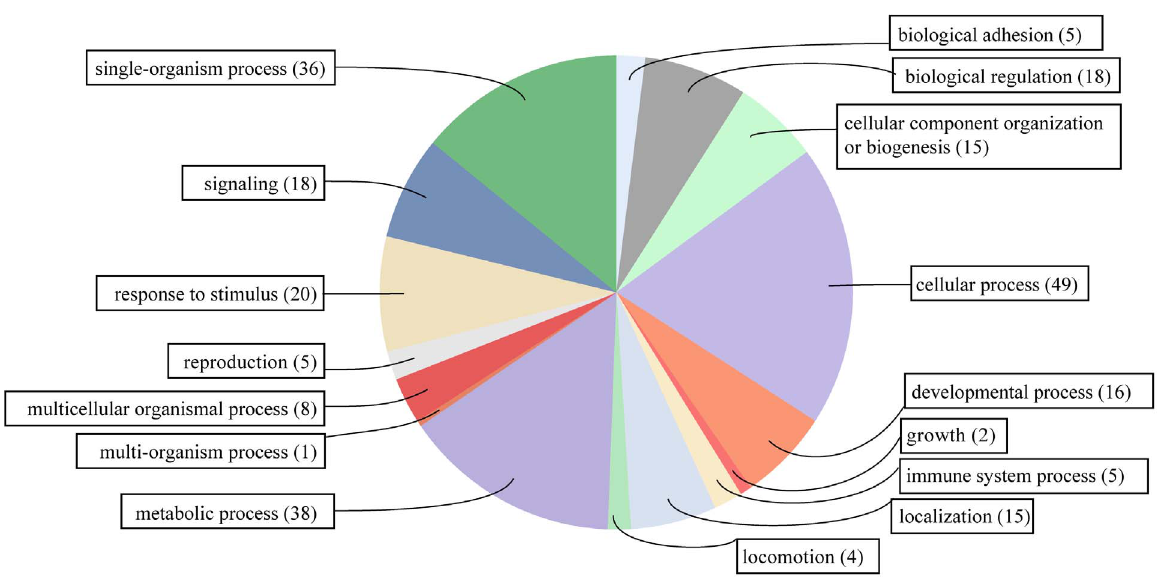
Figure 4. The category of biological process for the unique DEGs in the cot strain after hyperthermia induction. DEGs (Table S4) were broadly categorized according to their biological process. Numbers represent the actual number of